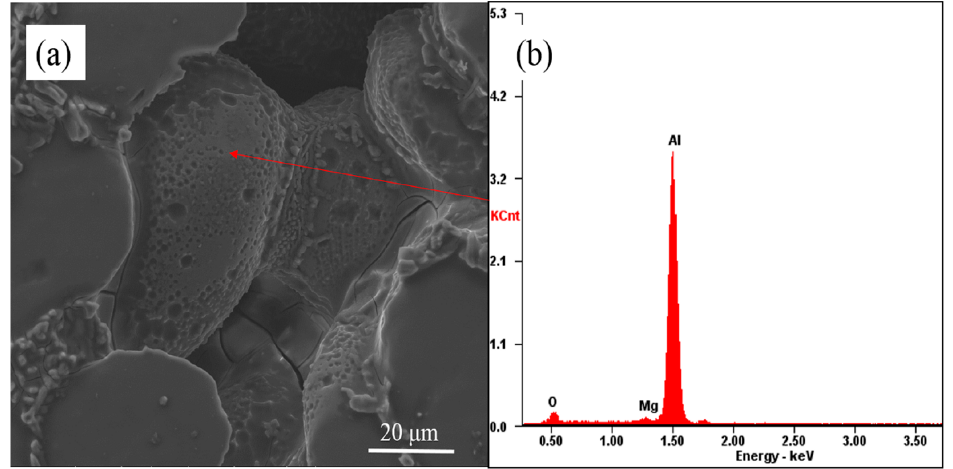
Figure 7. ( a ) The micro-morphology of A356 alloy scraps after being held in A356 alloy melt for 15 min; ( b ) Corresponding EDS results.